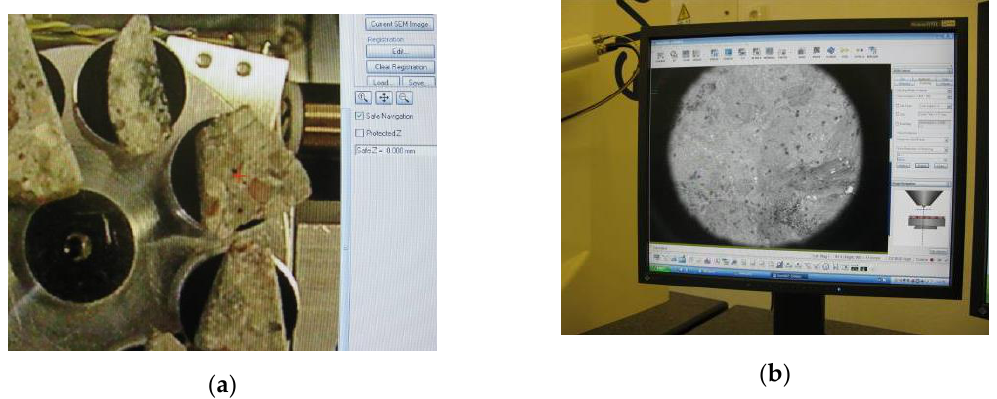
Figure 3. Temperature variation curve.